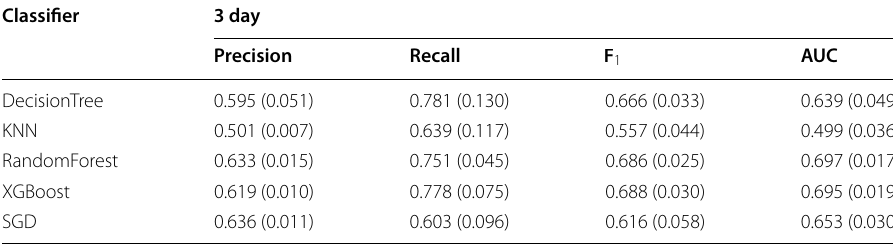
Table 5 Performance, mean and (standard deviation), of churn prediction models for the using first day features using the 3-day